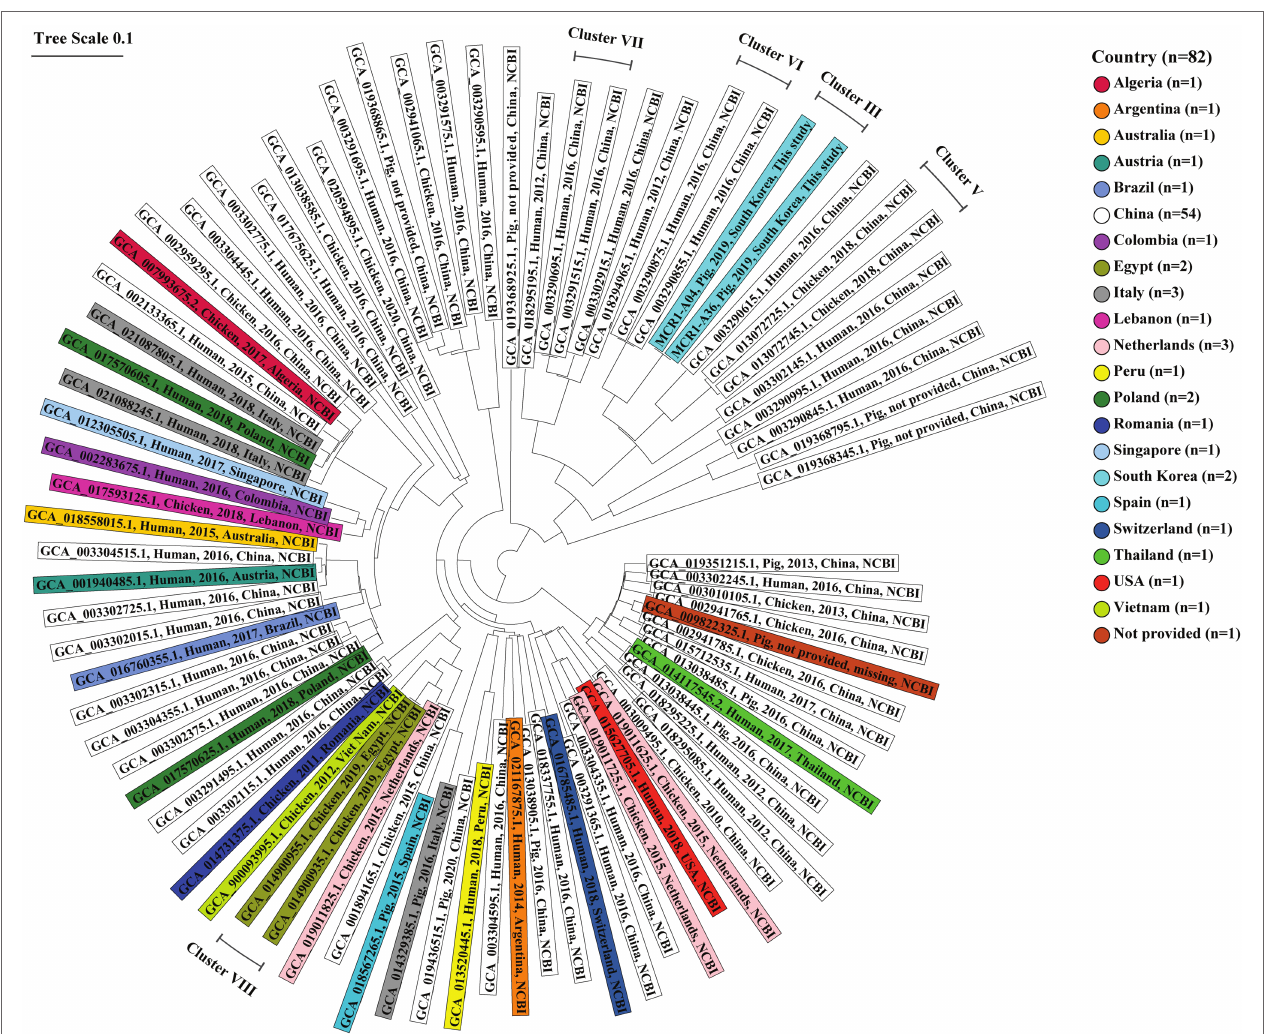
FIGURE 8 | Core genome multi-locus sequence typing-based genetic relatedness of 82 ST10-A MCR1-EC strains isolated from humans, pigs, and chickens worldwide. Strains were derived from the NCBI GenBank database. The phylogenetic tree based on cgMLST was constructed using the neighbor-joining algorithm with default parameters implemented in the Ridom SeqSphere+ program (v8.2.0). The shaded color corresponds to the country where the strain was isolated. The contents of shades include, from left to right, the assembly accession number, host, isolation date, isolation country, and data source (this study or NCBI database) for each strain. Five clusters consist of MCR1-EC isolates with a relatedness distance value of less than 0.01. MCR1-EC, Escherichia coli carrying the mobilized colistin resistance gene mcr-1.1 ; cgMLST, core genome multi-locus sequence